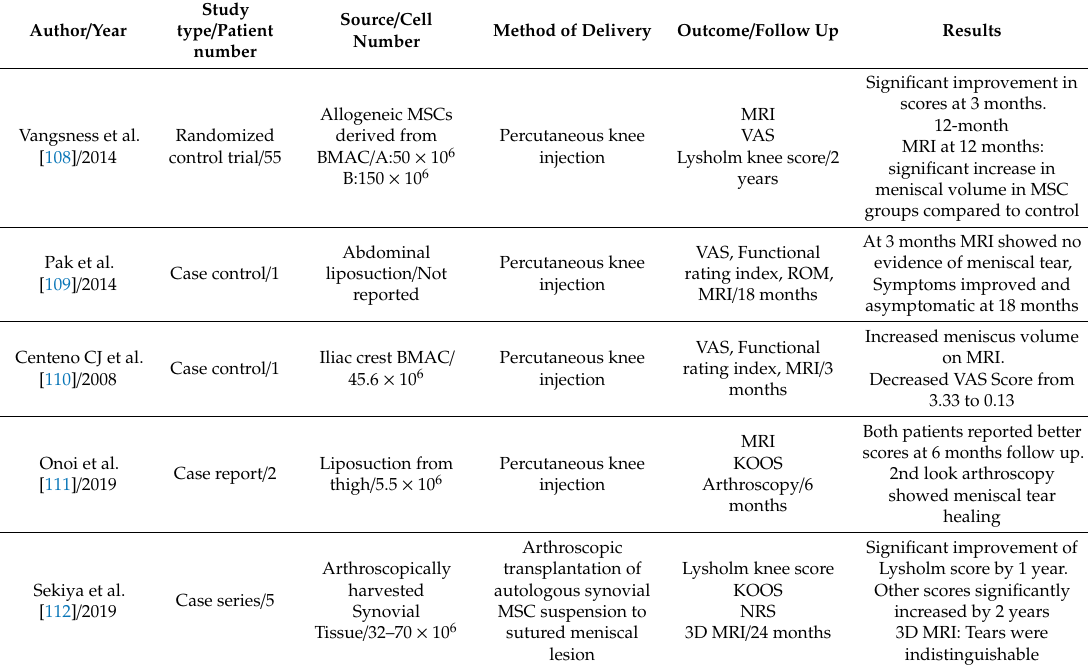
Table 4. Summary of clinical studies using stem cell